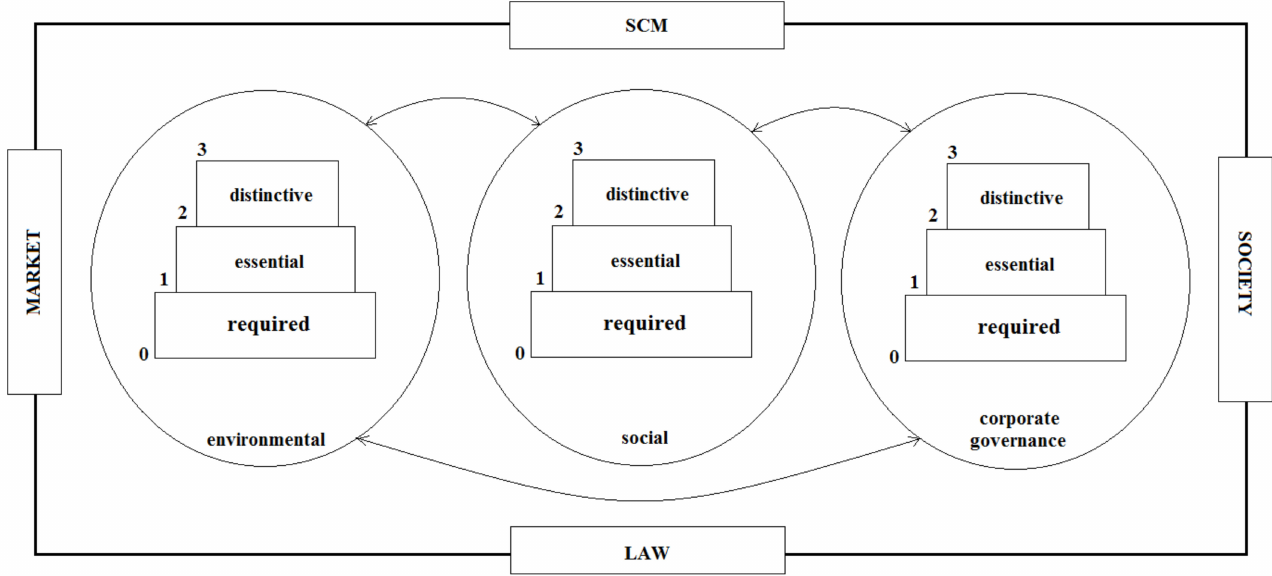
Figure 6. CSR model for companies producing and supplying